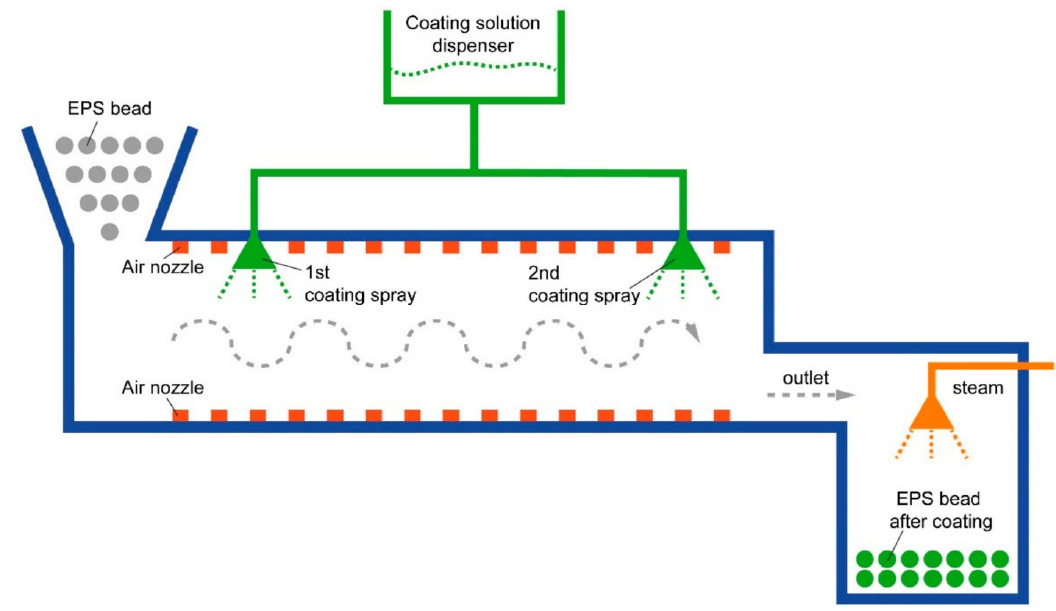
Figure 8. Flow chart of continuous spraying of flame − retardant materials onto the surface of molten expandable polystyrene (EPS) bead microspheres. Reprinted from Ref. [105].